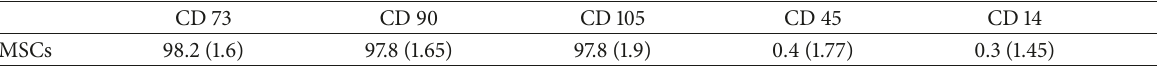
Table 4: Flow cytometry results.